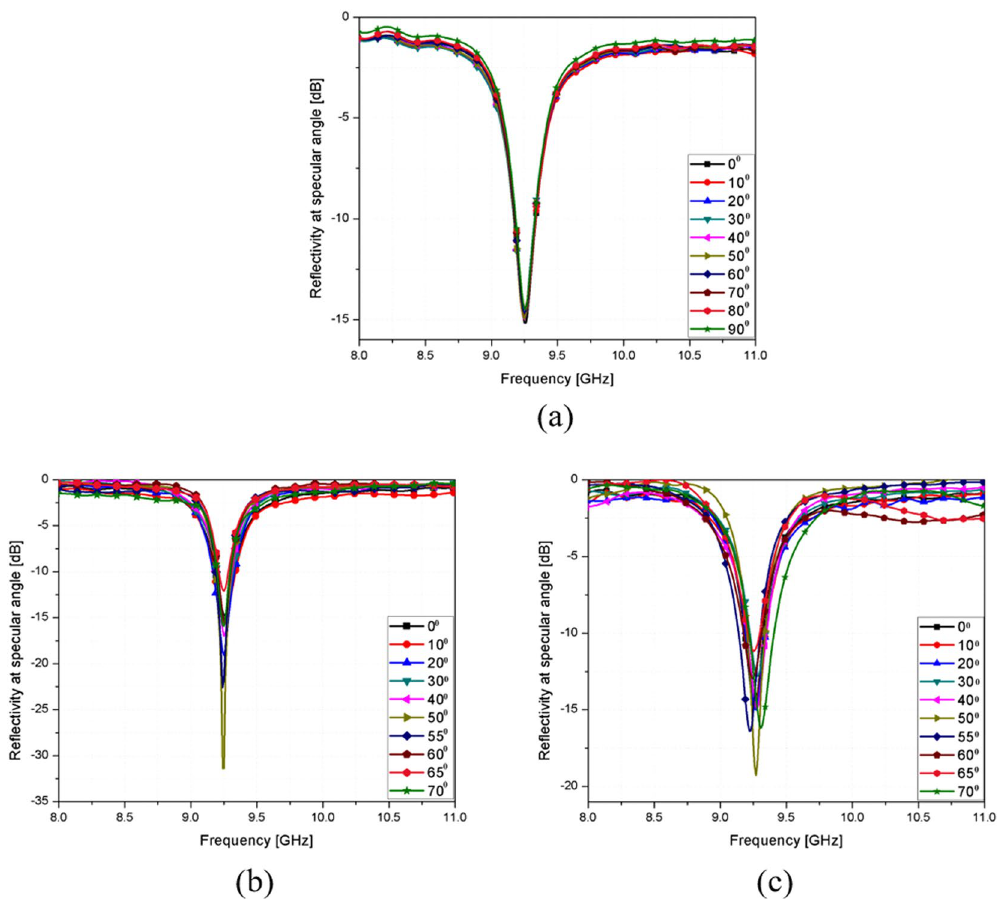
Figure 7. ( a ) Measured reflectivity of the proposed absorber for different polarization angles φ under normal incidence ranging from 0° to 90°. Measured reflectivity at the specular angle of the proposed absorber for incident angles θ ranging from 0° to 70° in ( b ) TE and (c) TM polarization.